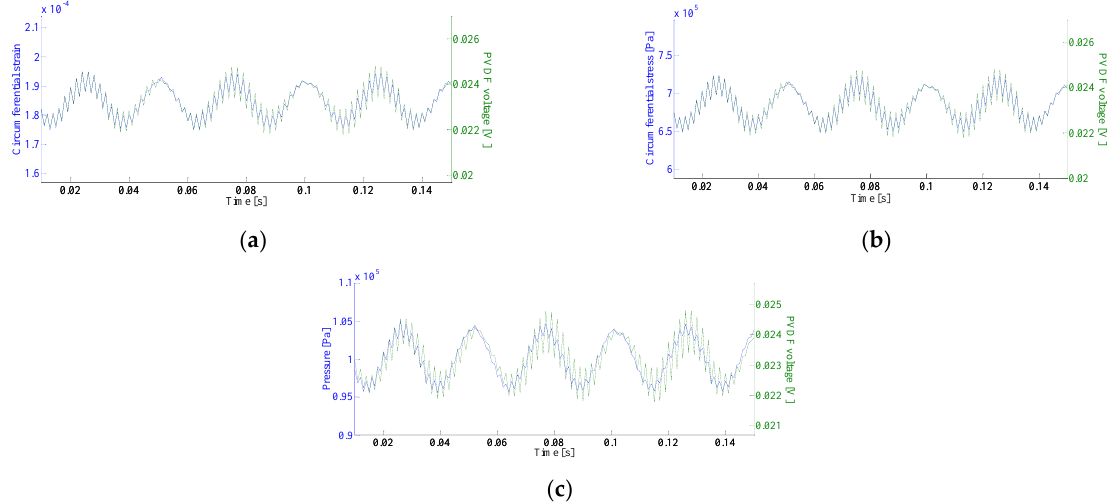
Figure 11. Comparison curves of ( a ) circumferential strain at Point2 and PVDF2 voltage; ( b ) circumferential stress at Point2 and PVDF2 voltage; ( c ) fluid pressure and PVDF2 voltage.